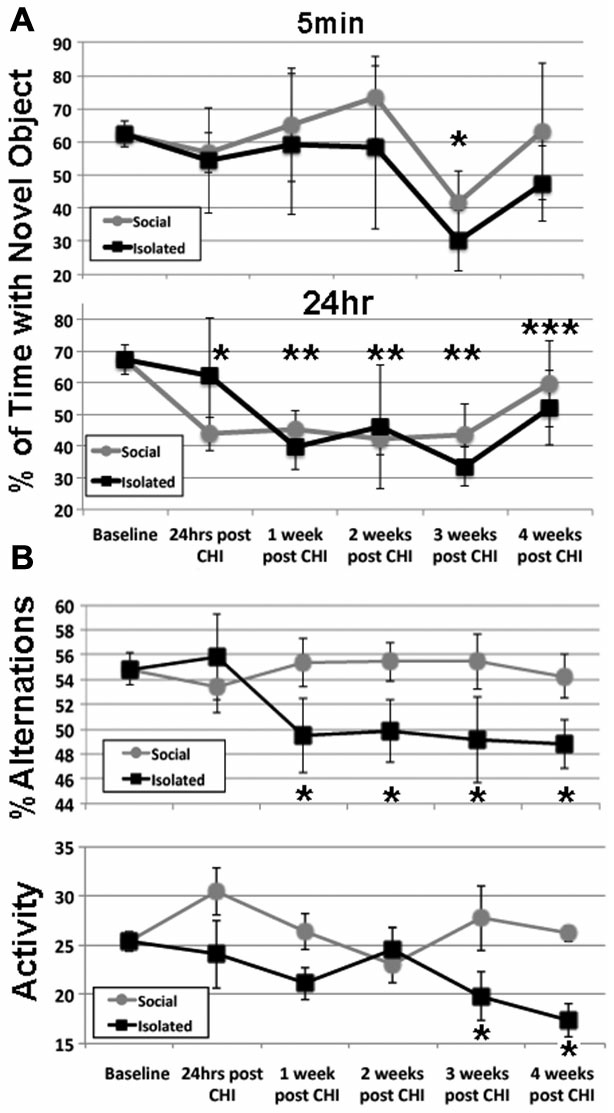
Closed head injury (CHI) impaired cognitive performance; exacerbation by isolation. (A) Presents at 5 min and 24 h after acclimation as indicated. Values represent the mean (± standard deviation) of the percentage of time devoted to the novel object (calculated according to the formula: seconds investigating novel object (seconds investigating novel object + seconds investigating familiar object). When tested 5 min after acclimation, both isolated and socially-housed mice displayed impaired performance at 3 weeks following CHI (asterisk; p < 0.07 and 0.01 vs. baseline for socially-housed and isolated mice, respectively. Both groups displayed novel object recognition (NOR) that did not differ from baseline at 4 weeks after CHI. When tested at 24 h after acclimation, socially-housed mice declined by 24 h after CHI (p < 0.05; single asterisk); isolated mice declined by an identical level by 1 week post CHI and both groups continued to display significantly impaired NOR until 3 weeks post CHI (p < 0.05; double asterisks). At 4 weeks post CHI, both social-housed and isolated mice displayed improvement in NOR (p < 0.07 and p = 0.05 vs. baseline, respectively; triple asterisks). (B) Presents the percent alteration and total activity as described in Materials and Methods. Socially-housed mice maintained performance in Y maze navigation identical to that at baseline for the entire 4 weeks following CHI. By contrast, mice housed under isolated conditions significantly declined in performance by 1 week following CHI, and continued to display significantly impaired performance for the entire 4 weeks (p < 0.05; asterisks). Isolated mice also displayed a significant (p < 0.05) decline in activity at 3 and 4 weeks following CHI as quantified by total changes in arms of the Y maze (p < 0.05; asterisks); socially-house mice maintained performance identical to that of baseline for the entire 4 weeks after CHI.